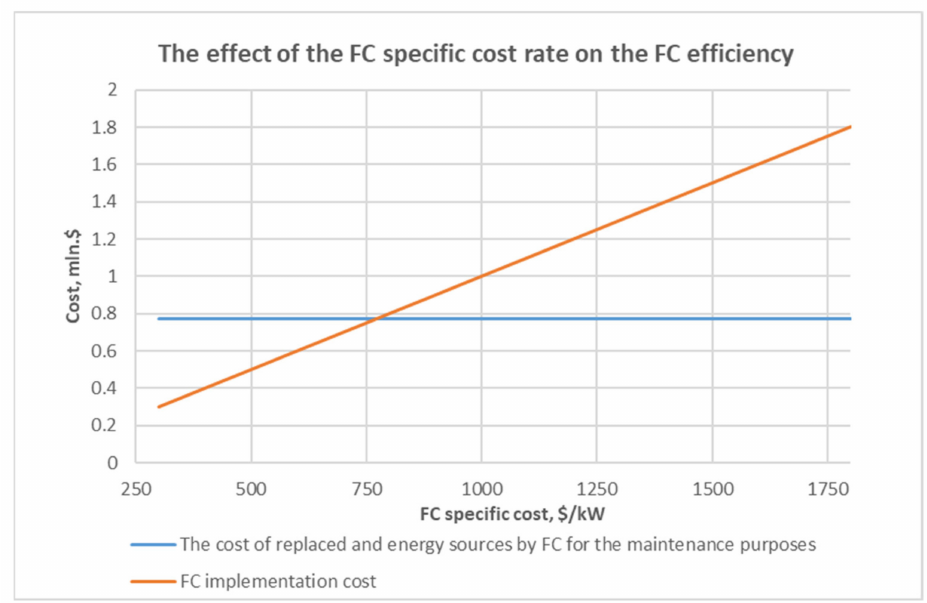
Figure 8. The effect of the FC specific cost rate on the FC efficiency in the case of covering the economic needs of the station by